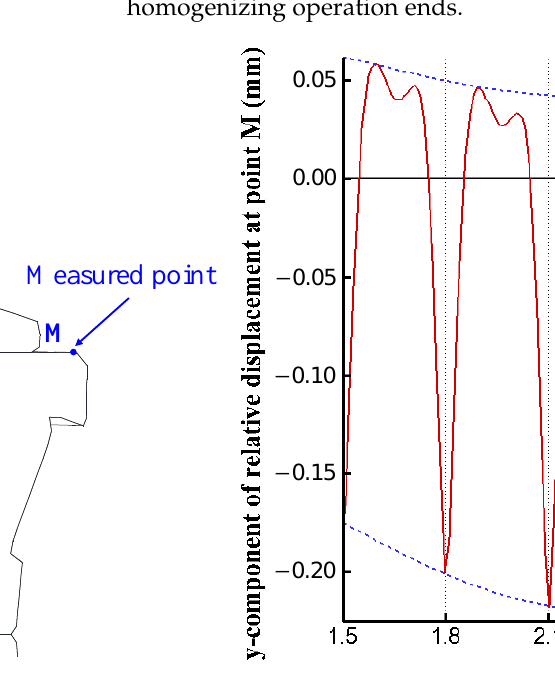
Figure 9. The y-displacement component of point M at the final position.